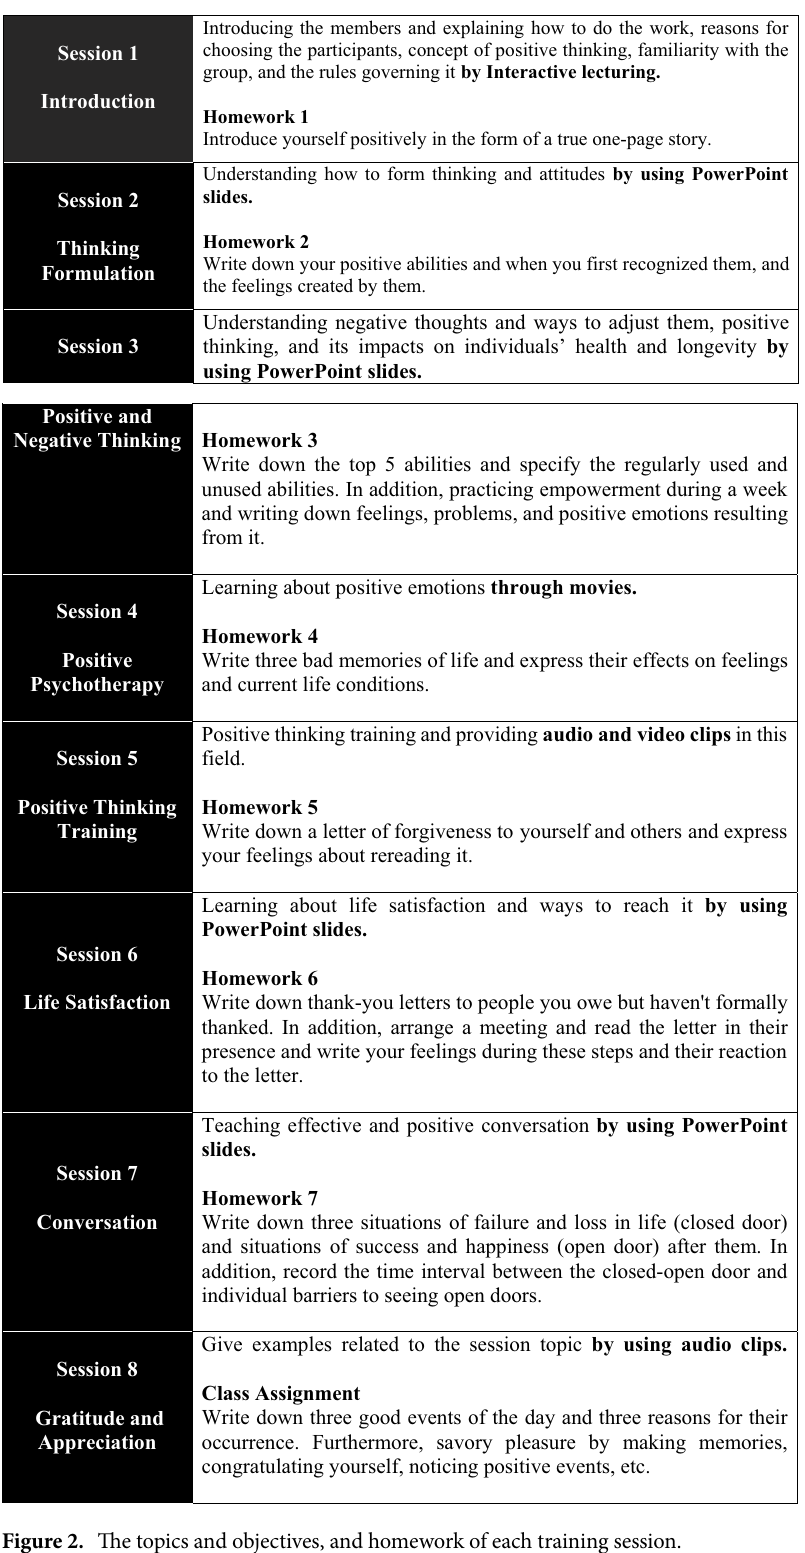
Figure 2. The topics and objectives, and homework of each training